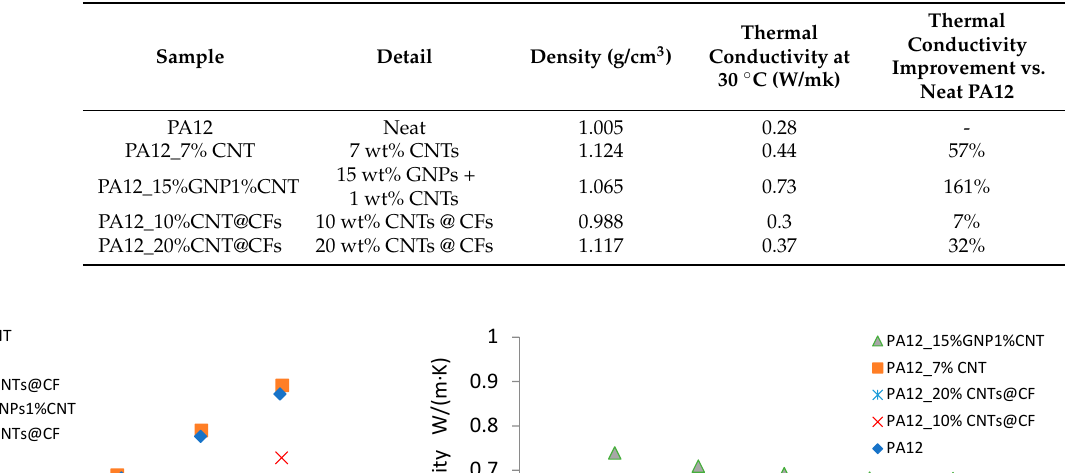
Table 3. Summary of PA12 compounds modified by different filaments.